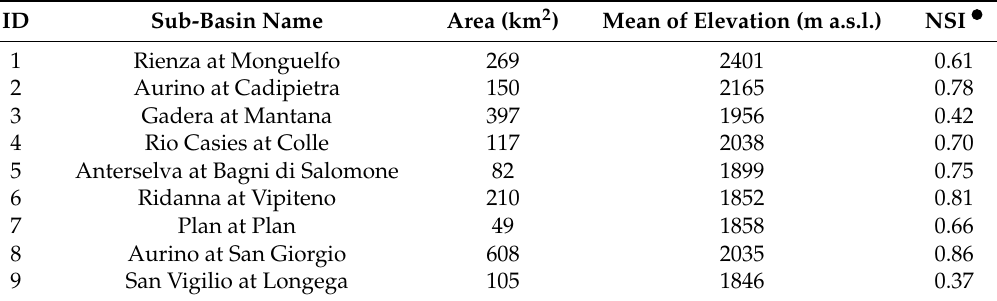
Table 1. Information of the study